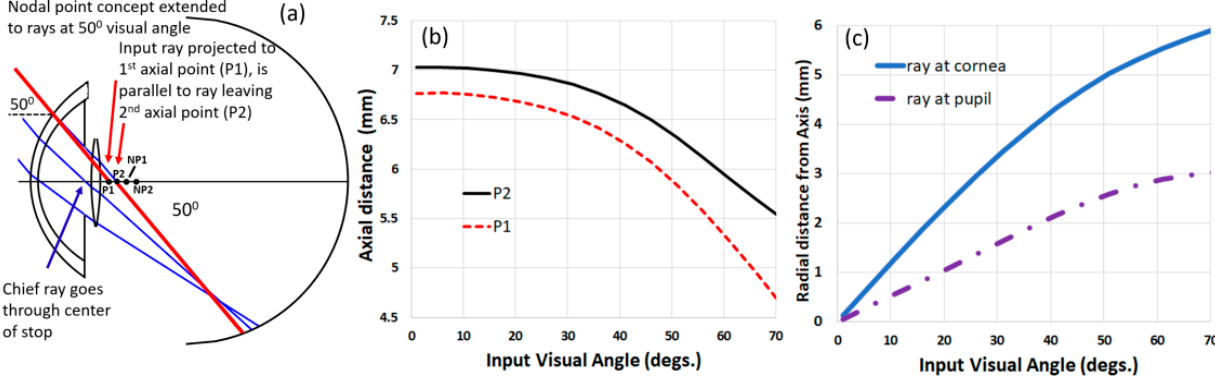
Figure 2. The nodal point concept extended to large angles. ( a ) Zemax drawing. ( b ) Axial distance from corneal apex of points with identical input and output angles as visual angle increases (P1 and P2). ( c ) Radial distance from axis at cornea and pupil for points in ( b